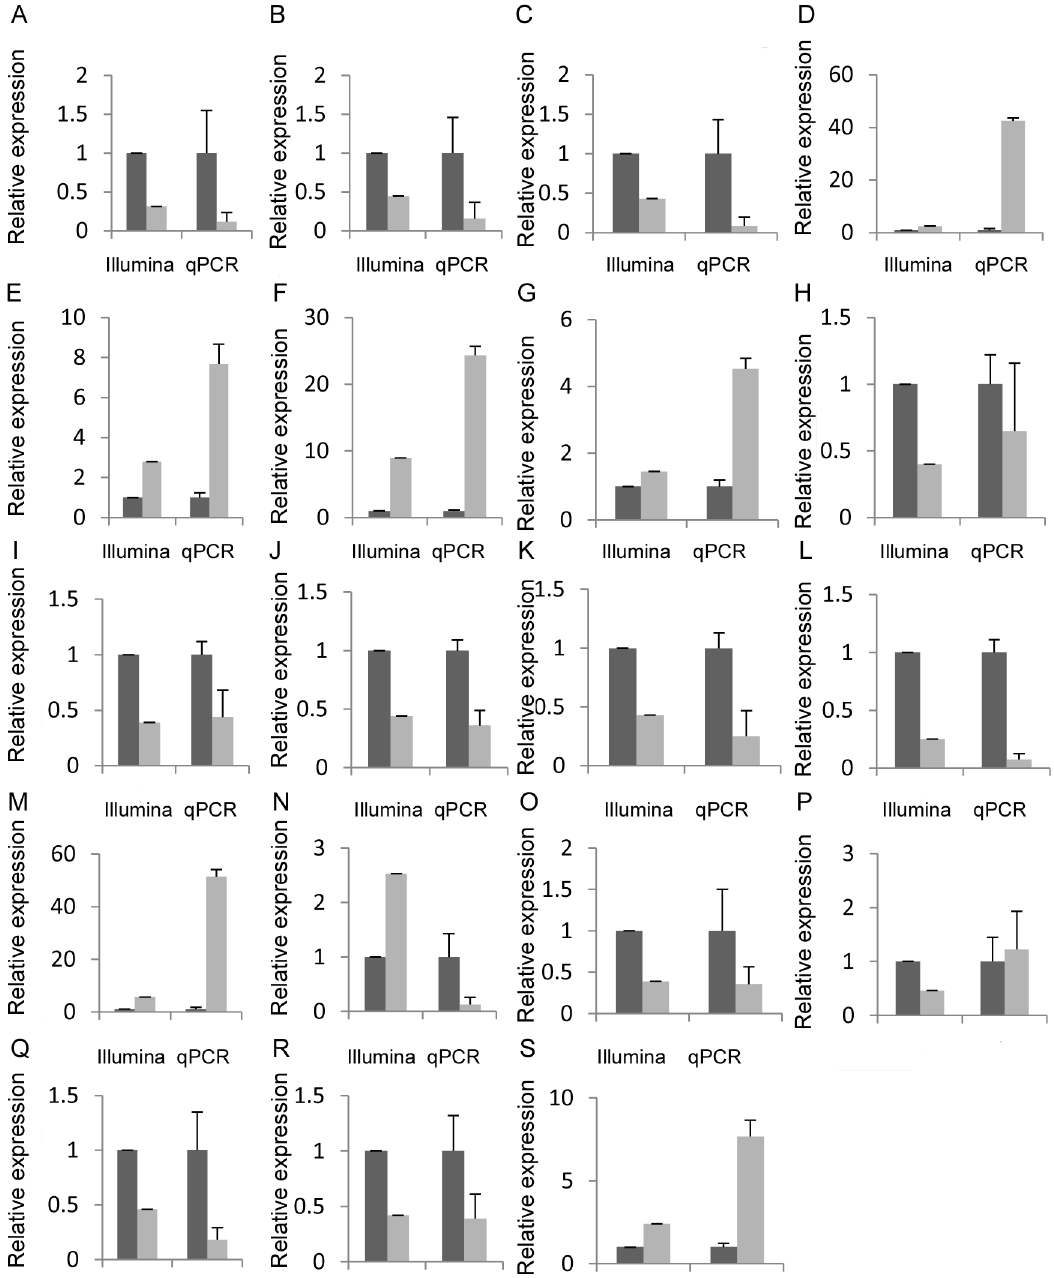
Fig 4. Validation of 19 genes differentially expressedbetween female and male flowers using qRT-PCR. These differentiallyexpressedgenes encodeV-type proton ATPase subunit E (A), DELLA protein GAI (B), Putative leucine-rich repeat receptor-like protein kinase family protein (C), Putative uncharacterized protein OSJNBb0014M19.23–2 (D), Male sterility MS5 (E), Tapetum-specific protein A9 (F), Pollenole e 1 allergenand extensinfamily protein (G), Flowering promoting factor-like protein (H), Transcriptionfactor MYC (I), WRKY transcriptionfactor (J), Transcription factor MYC2 (K), Pistil-specific extensin-like protein (L), Unknownprotein (M), MYB transcription factor (N), Mitochondrial phosphate carrier protein (O), Nudix hydrolase 2 (P), Ethylene responsivetranscription factor 12 (Q), Ubiquitincarboxyl-terminal hydrolase(R) and Small ubiquitin-relatedmodifier2 (S).